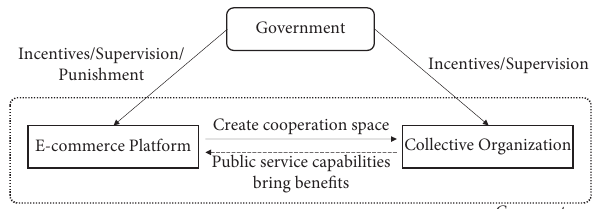
Figure 1: The system diagram of the E-commerce intellectual property social cogovernance with the collective